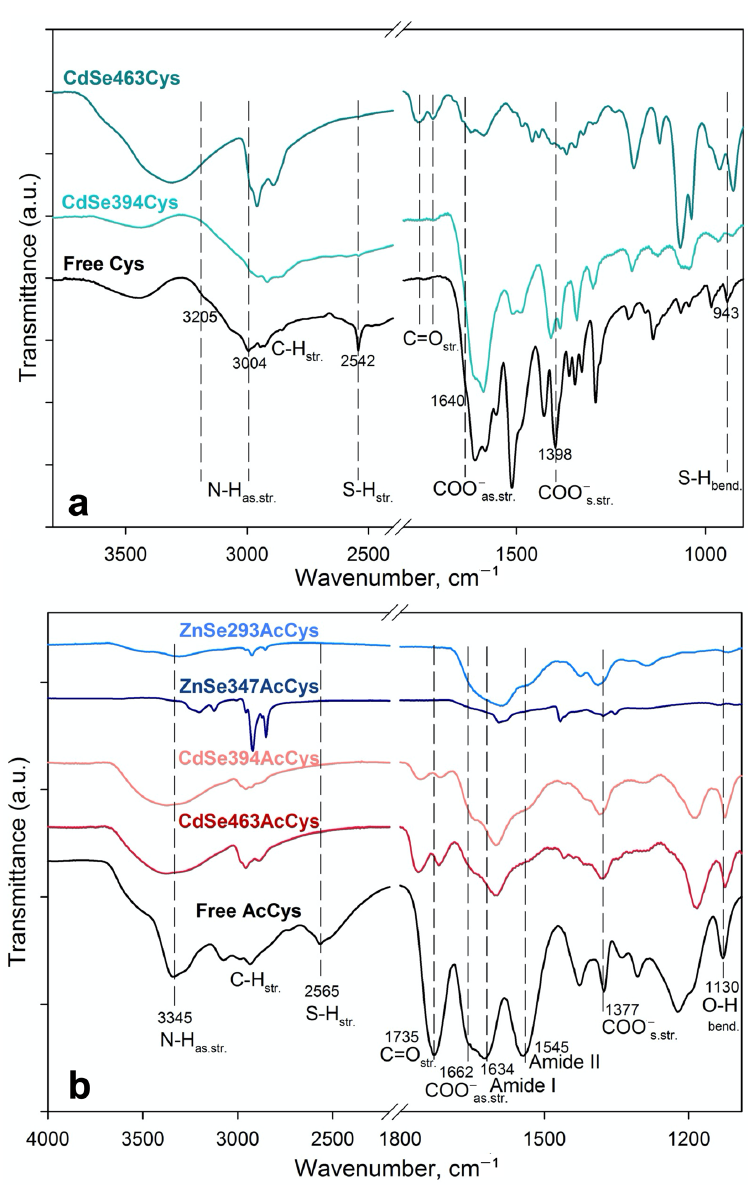
Figure 2. ( a ) FTIR spectra of L-cysteine capped 2.5 ML thick CdSe394Cys (dark green line) and 3.5 ML thick CdSe463Cys (turquoise line) samples. Black line shows the FTIR spectrum of pristine free L-cysteine reference. ( b ) FTIR spectra of N-acetyl-L-cysteine ligand capped 2.5 ML thick ZnSe293AcCys (blue line), 4 ML thick ZnSe347AcCys (dark blue line), 2.5 ML thick CdSe394AcCys (pink line), and 3.5 ML thick CdSe463AcCys (red line) samples. Black line shows the FTIR spectrum of pristine free N-acetyl-L-cysteine reference. Positions of the main vibration bans are marked by dashed lines. The spectra are offset for clarity.